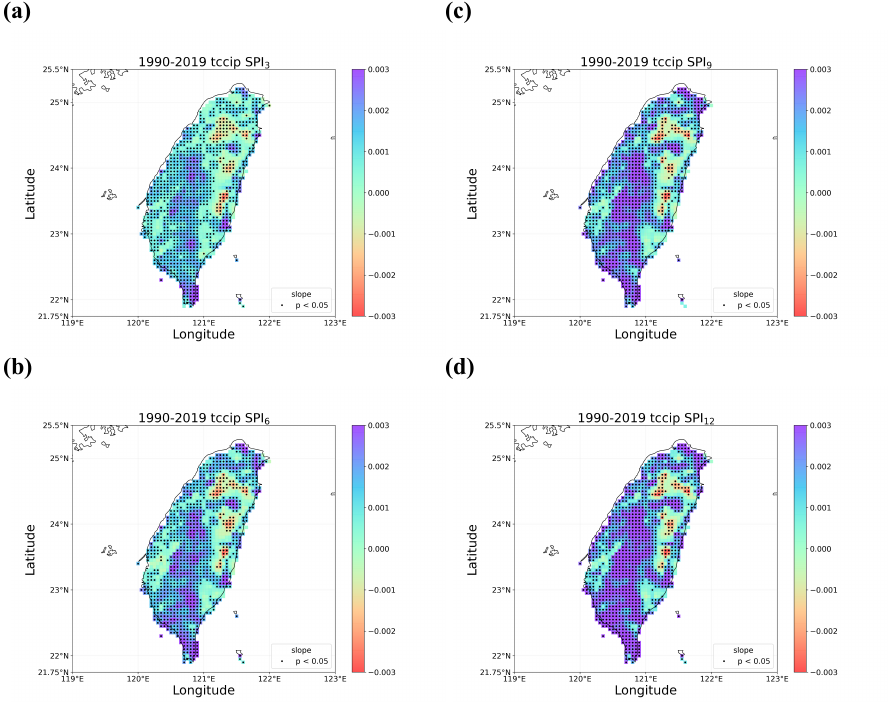
Figure 10. Spatial patterns of trends in the SPI series in the later period (1990–2019) detected using linear regression; ( a – d ) the SPI at 3-, 6-, 9-, and 12-month